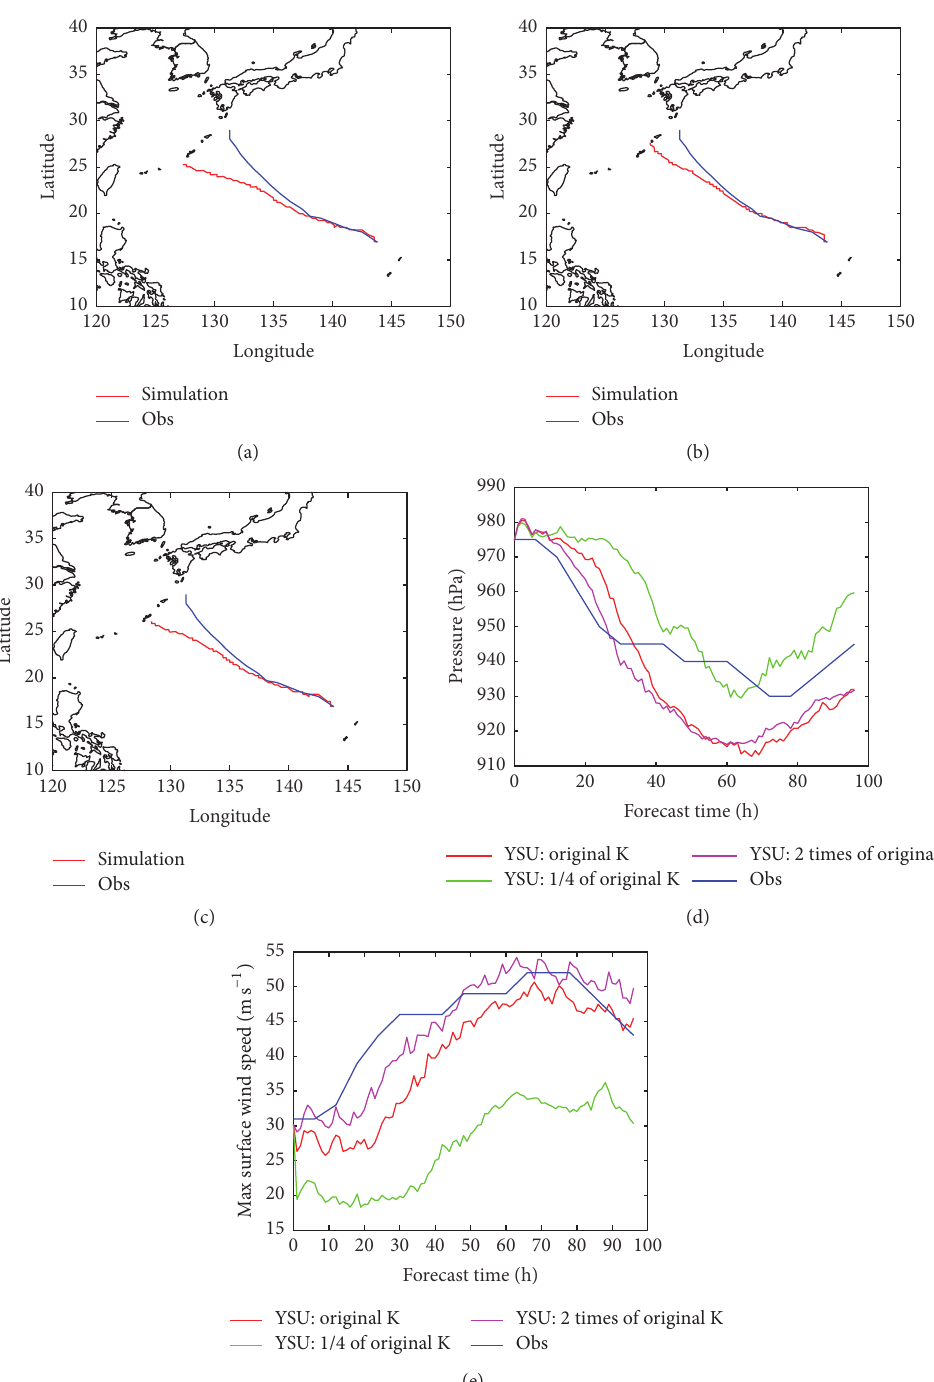
Figure 5: Case 4-Phanfone: (a) track simulated by the original YSU; (b) track simulated by the K025; (c) track simulated by the K200; (d) comparisons of center sea-level pressure; and (e) comparisons of maximum surface wind speed.